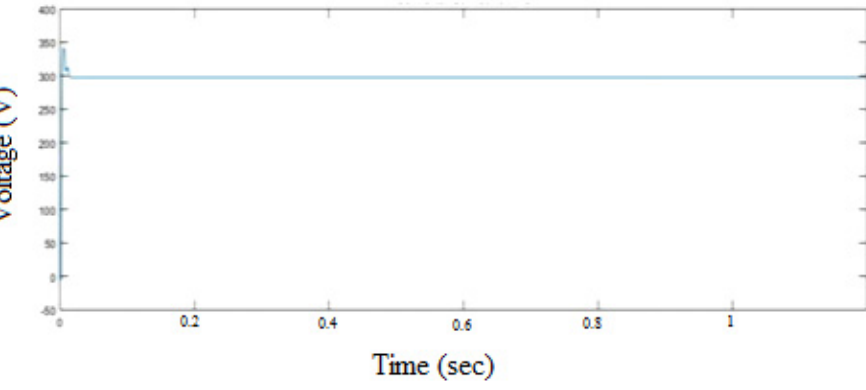
Figure 7. Converter output voltage waveform. Figure 7.Converter output voltage waveform.